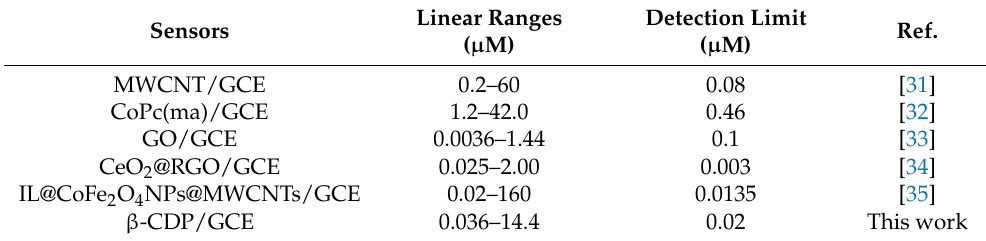
Table 1. Comparison of different electrochemical sensors for the determination of FNT.